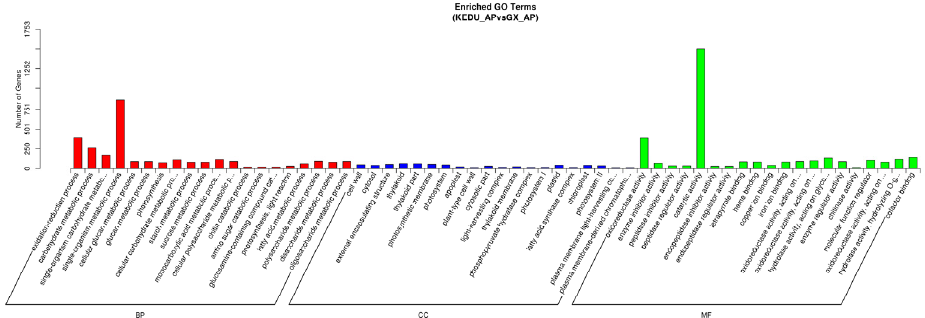
Figure 4. Differentially expressed genes (DEGs) identified between KEDU_AP and GX_AP. The red dots represent significant up ‐ regulated genes and the green dots represent down ‐ regulated genes.